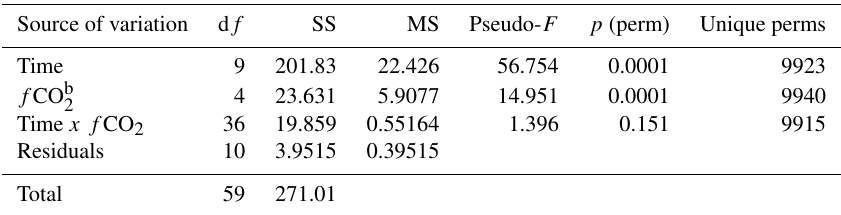
Table 5. Results of two-factor permutational multivariate analysis of variance (PERMANOVA) a on a resemblance matrix (Bray–Curtis similarity coefficient) based on log( X + 1) transformed abundances of Pico I-III, Nano I-II, FL bacteria (HDNA, LDNA), PA bacteria, SYN and Chl a . Degrees of freedom (d f ); sum of squares (SS); mean square (MS).